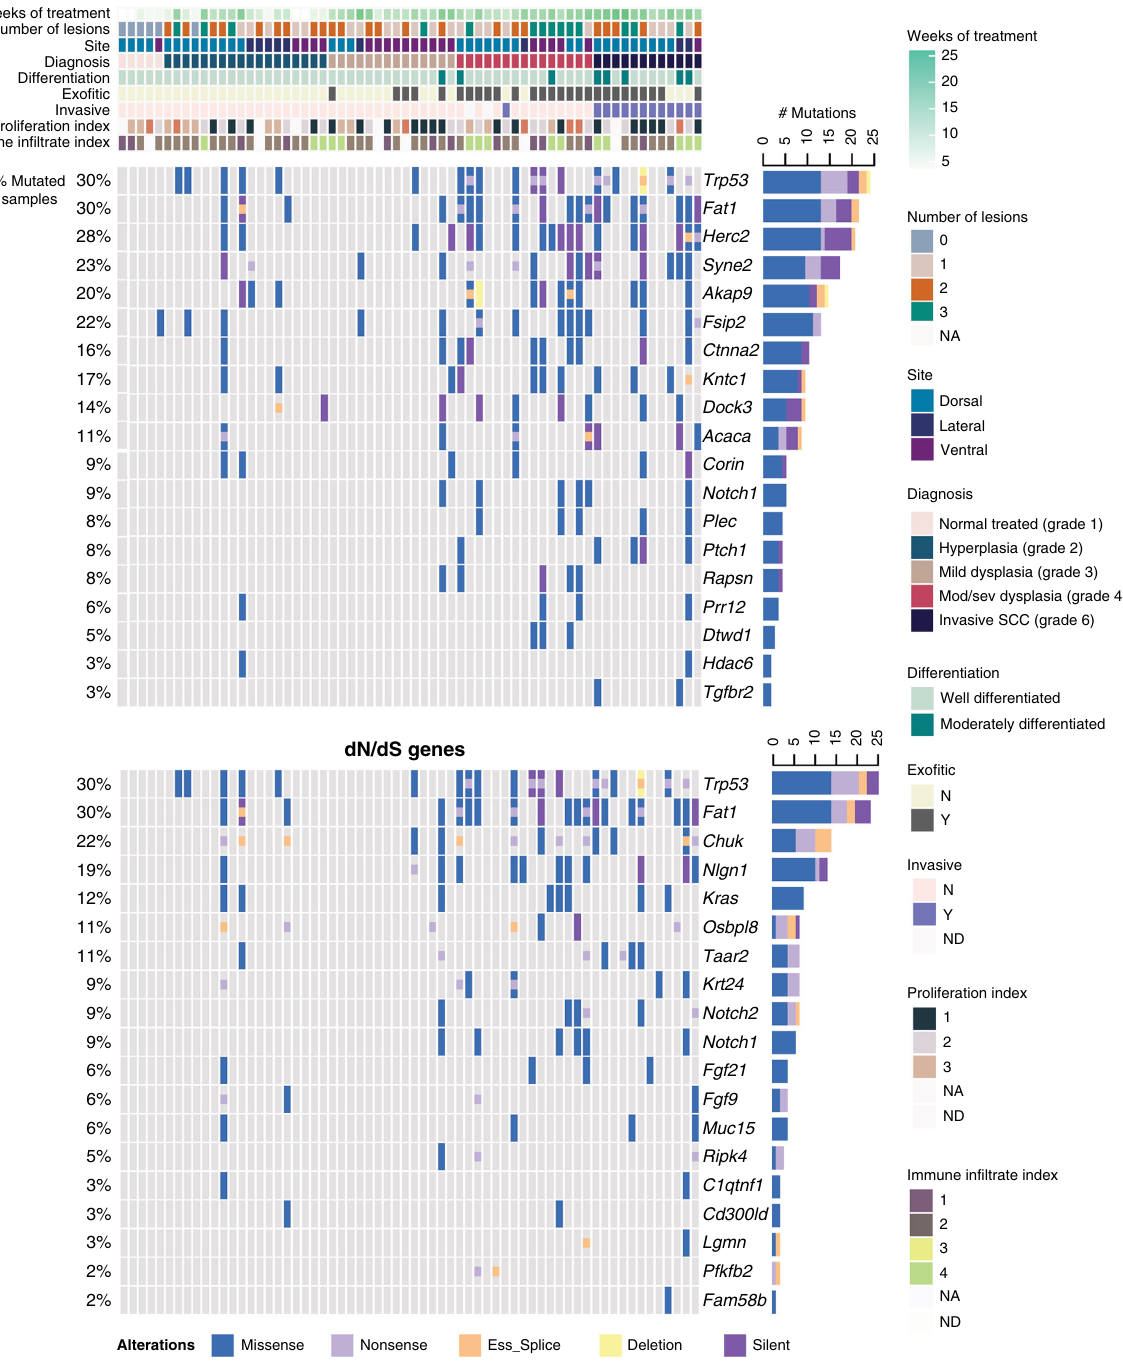
Fig. 2 Data matrix showing mutational landscape of 4NQO-induced TSCCs compared with tumour ecology, including recurrent somatic mutations. The top panel shows the key clinical parameters: colour coding indicates number of weeks of treatment, number of lesions per tongue, site of the sequenced lesion (dorsal, ventral or lateral), diagnosis (tumour-grade), differentiation status, exophytic tumour (yes/no), invasive tumour (yes/no), proliferation index, and immune-in fi ltrate index (CD45 + cells) (Supplementary Data 1 2 and 3). The middle and the bottom panels show the signi fi cantly mutated genes (rows; tongue recurrently mutated genes and a subset of dNdS genes, respectively) coloured by the types of mutation. Samples (columns, n = 65) are organised by diagnosis by increasing grade. Somatic mutations are presented according to the type of mutation (missense, nonsense, exonic splicing silencer ‘ Ess_Splice ’ , deletion or silent mutations; colours de fi ned in key). All mutations are listed in Supplementary Data 3, 4 and 5. The distribution between the types of somatic alterations for each gene is shown in the histogram (right). Percentages on the left represent the fraction of tumours harbouring mutations in the corresponding